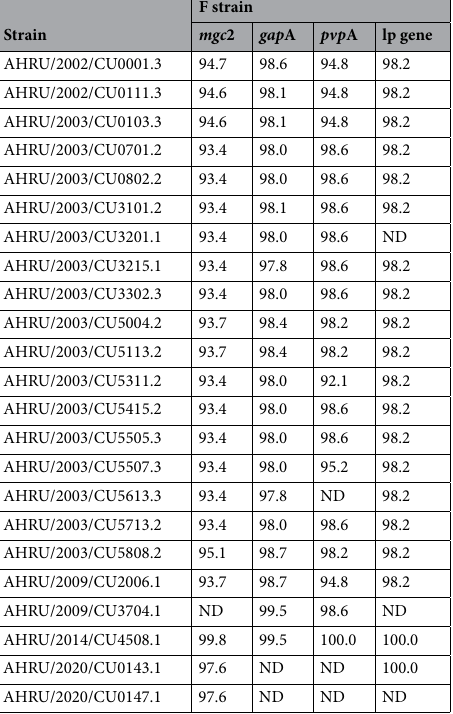
Table 2. The genetic similarity (%) between the F strain and Thai MG isolates (Estimated from the number of base substitutions using the maximum composite likelihood model). ND not detected.